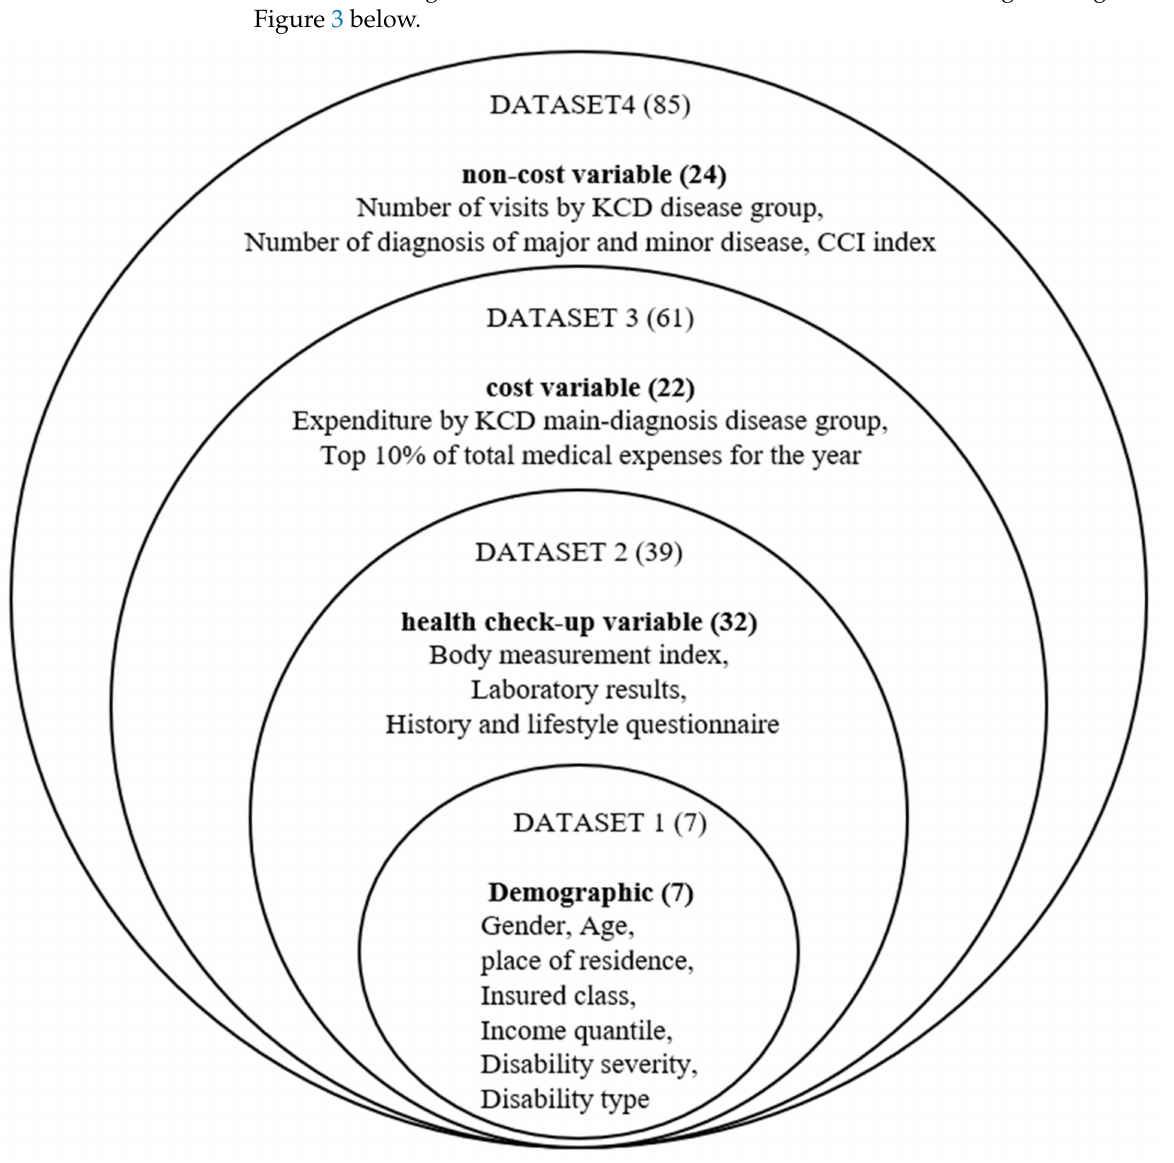
Figure 3. Variable diagram of